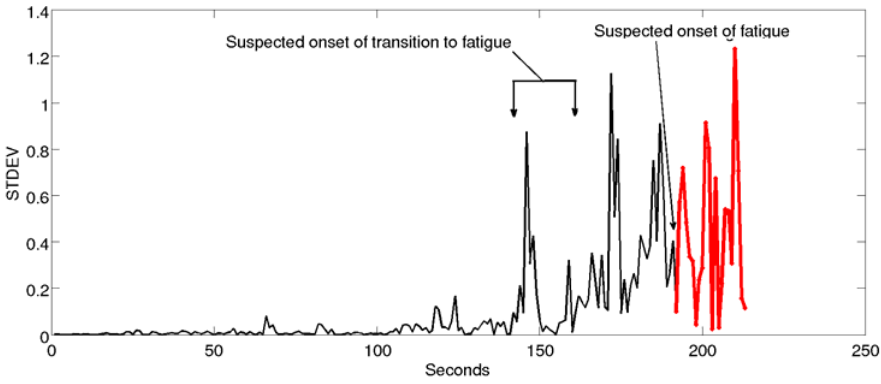
Figure 4. Illustration of the three classes of fatigue for one of the